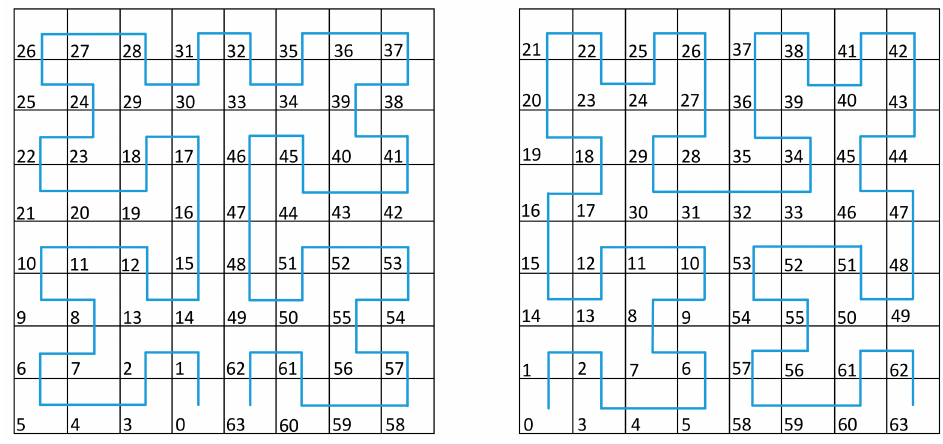
Figure 1. Moore curve and Hilbert